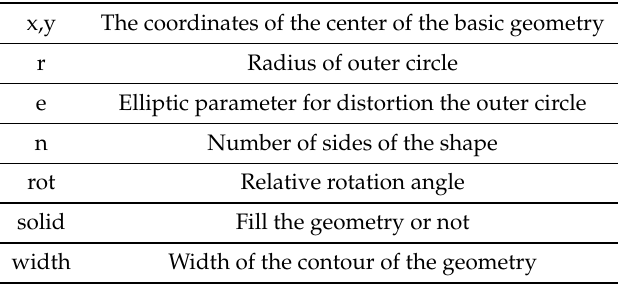
Table 1. Parameters of basic geometry